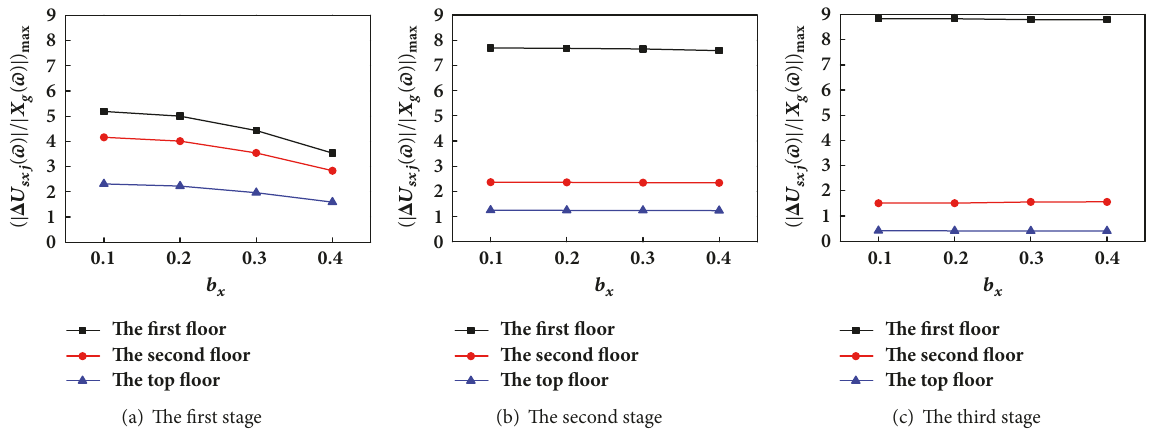
Figure 15: Interstory translation displacement in the 𝑥 direction under different 𝑏 𝑥 values.